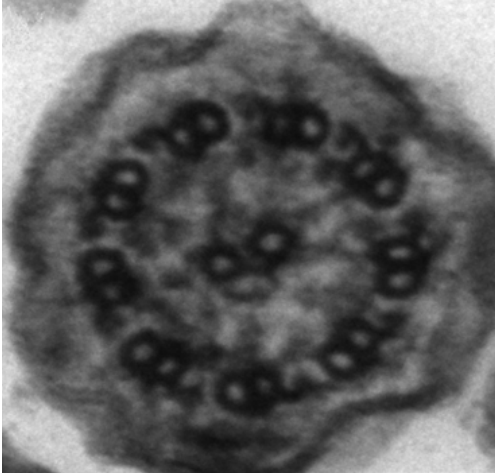
Figure 2. Scanning electron microscope image of a human cilium with normal